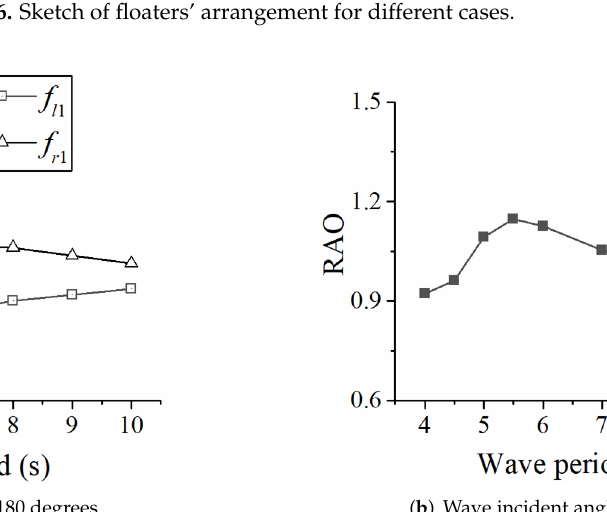
Figure 7. Heave motion response of floaters in different wave periods (one floater on one